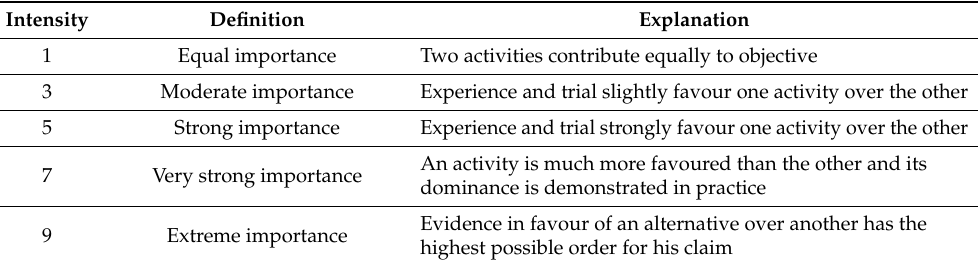
Table 2. Fundamental scale [53].